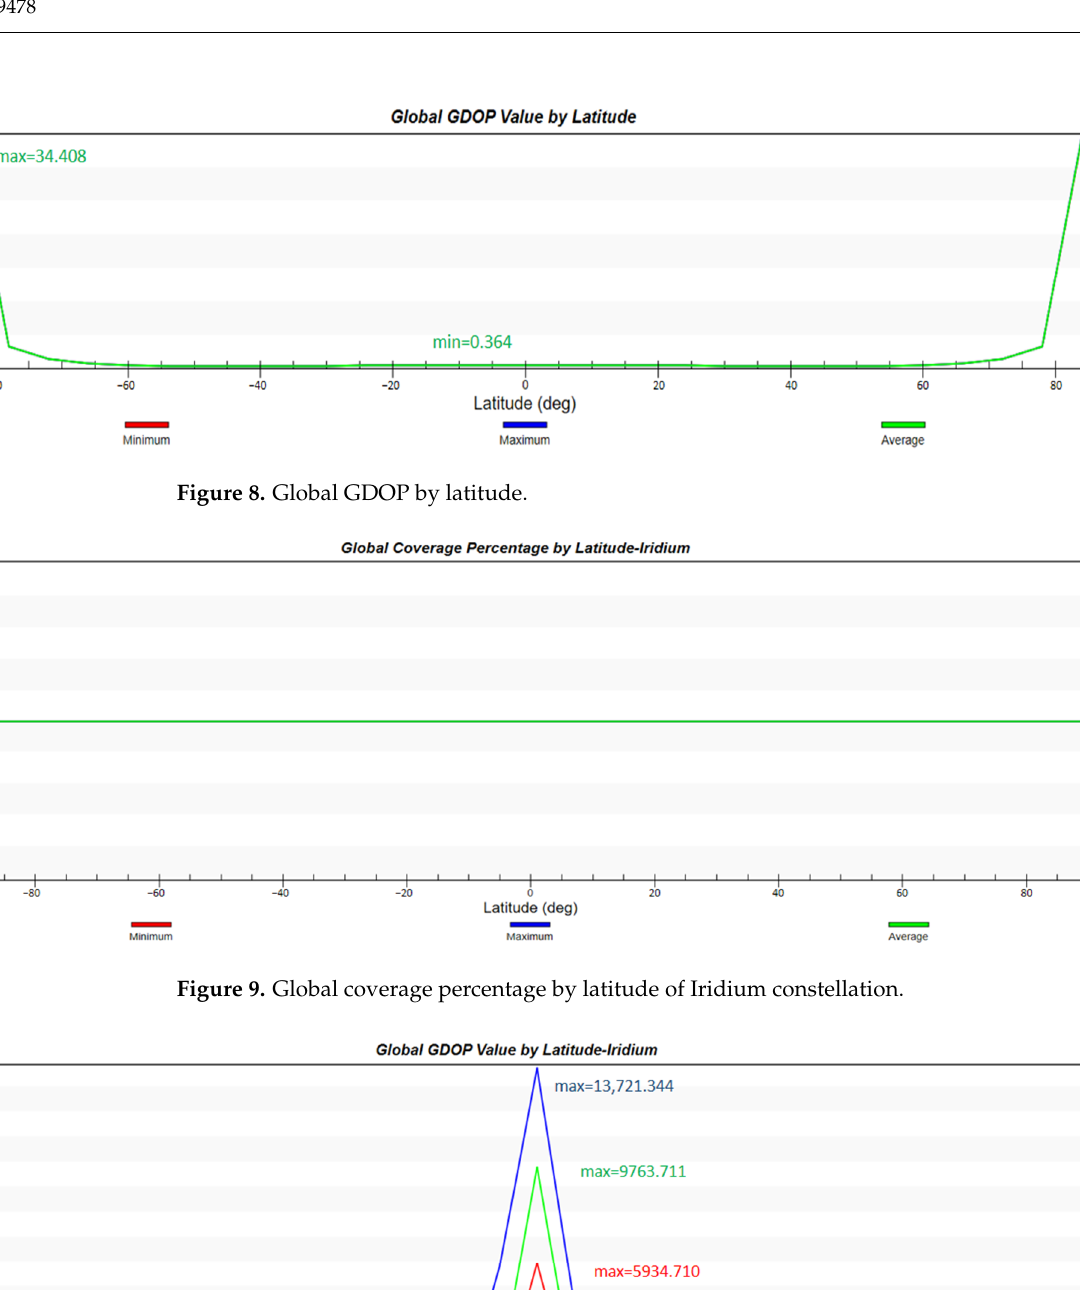
Figure 9. Global coverage percentage by latitude of Iridium constellation.